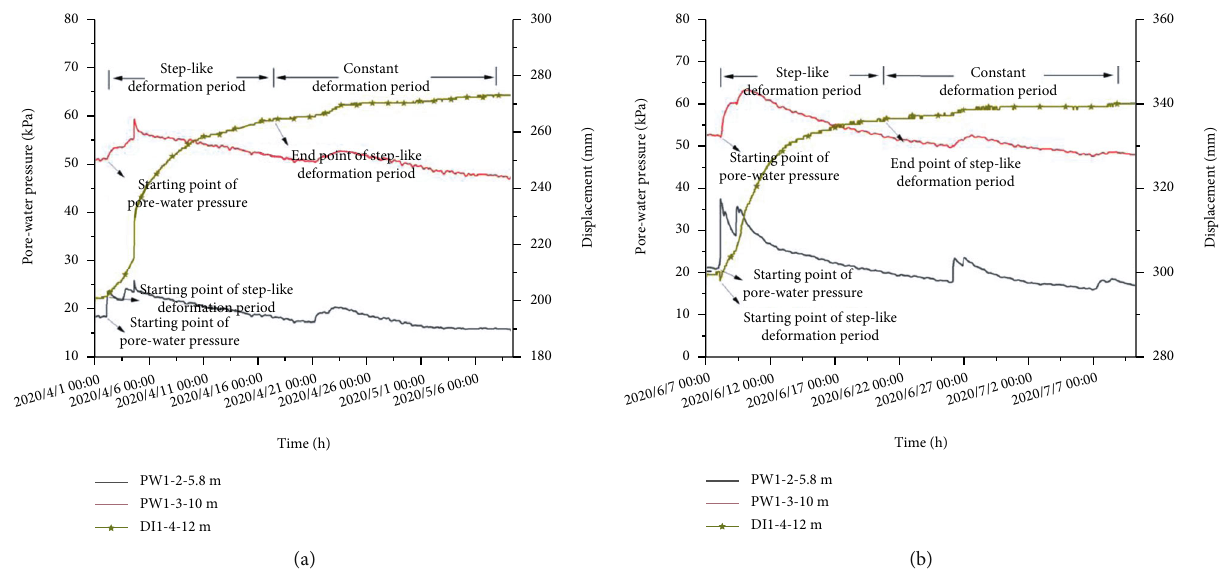
Figure 10: Relationship curve between displacement near the slip surface and pore-water pressure at di ff erent depths of point A in the study area. (a) April 1, 2020, 0:00 ~ May 10, 2020, 0:00. (b) June 7, 2020, 0:00 ~ July 10, 2020,